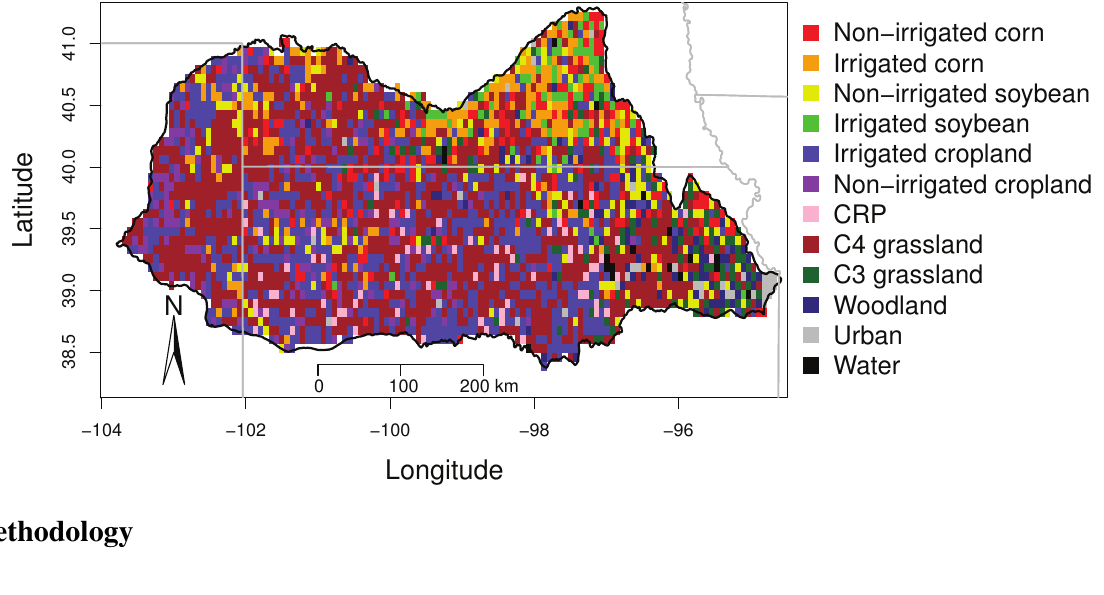
Figure 2. Distribution of land cover types in the Kansas River